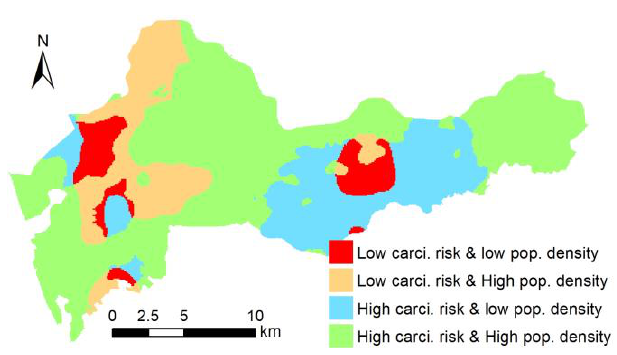
Figure 4. Spatially explicit management zones integrating carcinogenic risk and population